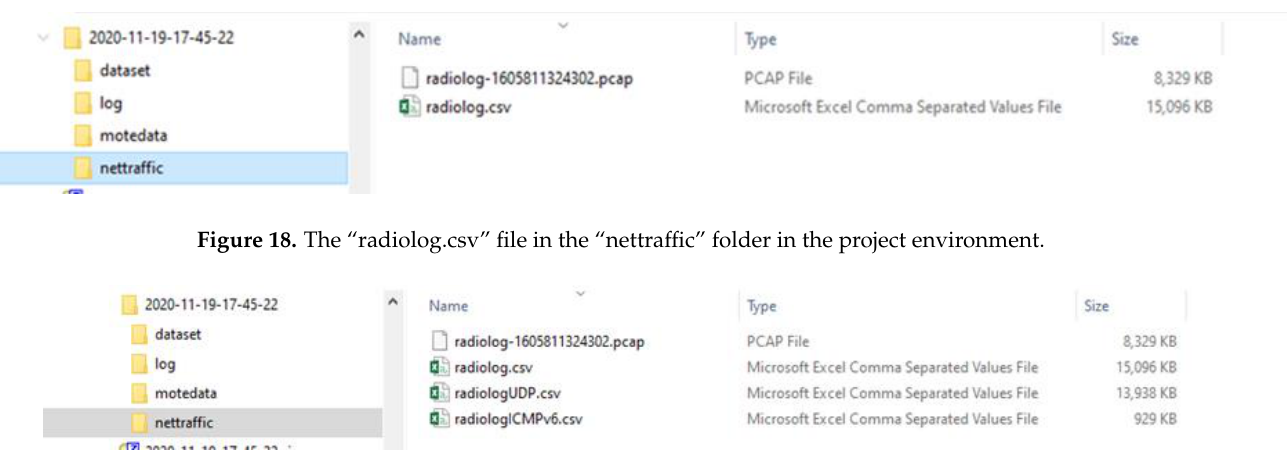
Figure 18. The “radiolog.csv” file in the “nettraffic” folder in the project environment .